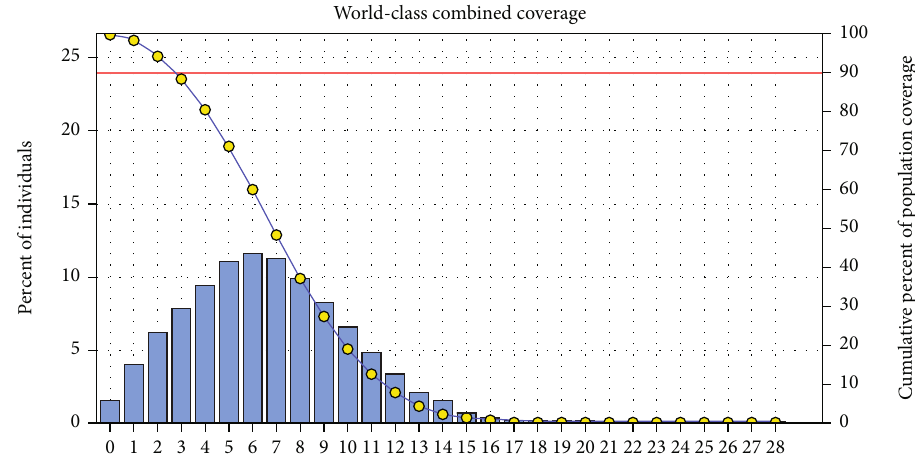
Figure 7: Global population proportion for the top fi ve MHC I and II epitopes in combined mode (IAPAYGIPV, AAFGNVHGV, VVAALEAAR, YIRSTIAPAY, and YQAGMVVLS). Notes: in the graphs, the line (-o-) represents the cumulative percentage of population coverage of the epitopes; the bars represent the population coverage for each epitope.